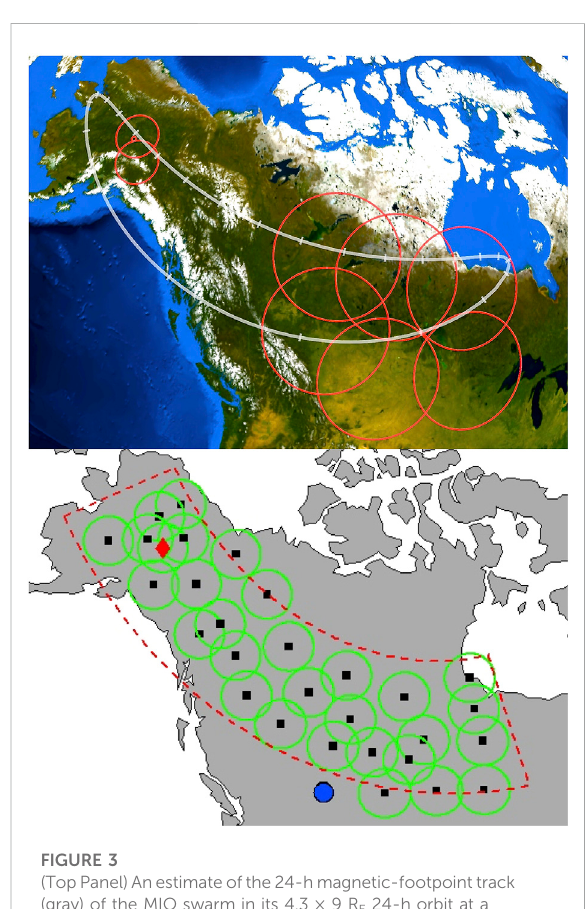
FIGURE 3 (TopPanel)Anestimateofthe24-hmagnetic-footpointtrack (gray) of the MIO swarm in its 4.3 × 9 R E 24-h orbit at a magnetospheric-activity level of Kp = 2: the large red circles are the fi elds of view of the present-day TREx camera network and the smaller red circles are the ranges of the PFISR and HAARP ionospheric facilities. (Bottom Panel) The locations costed for the extended TREx array of 29 optical imagers (black squares): the red triangleisFairbanksbetweenthelocationsofthePFISRandHAARP ionospheric facilities and the blue dot is the location of the University of Calgary ground